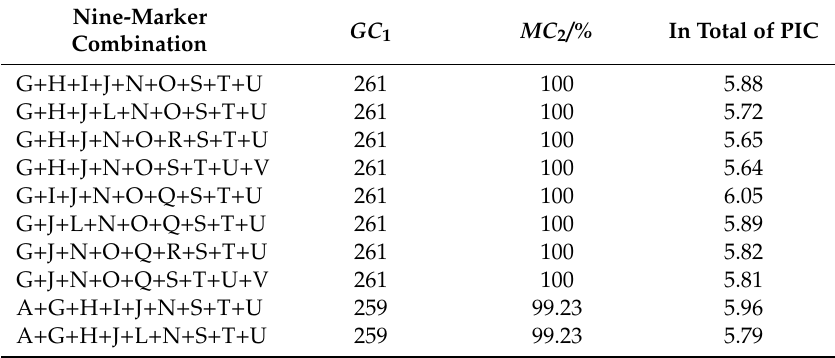
Table 2. The di ff erential index of nine-marker